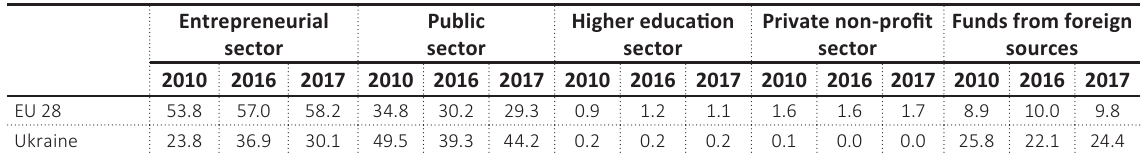
Table 1. The share of financing of R&D expenses in the total volume of R&D expenses by